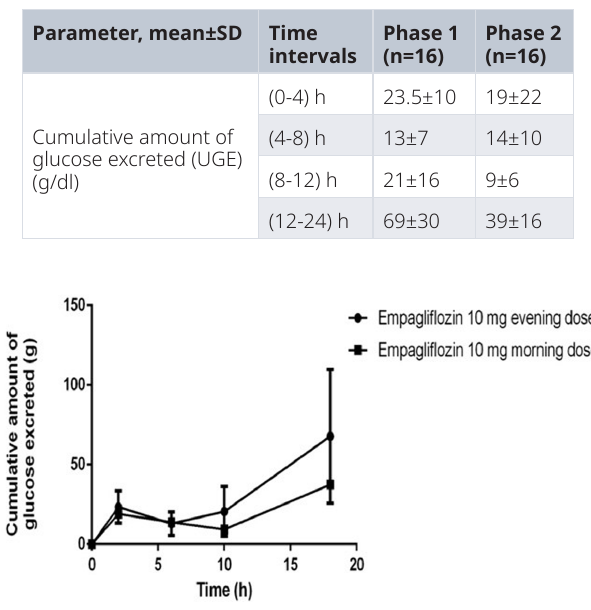
Table 2. Cumulative amount of glucose excreted after single dose administration of empagliflozin 10 mg.